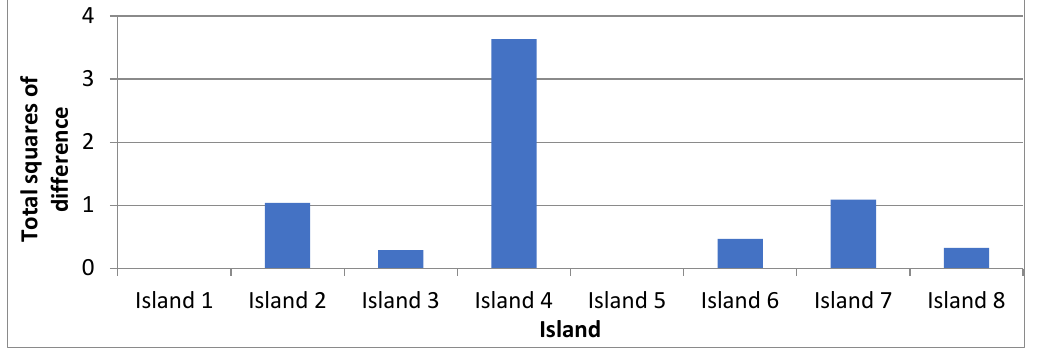
Figure 5. Total squares of difference for normalized monthly power consumption with islands.